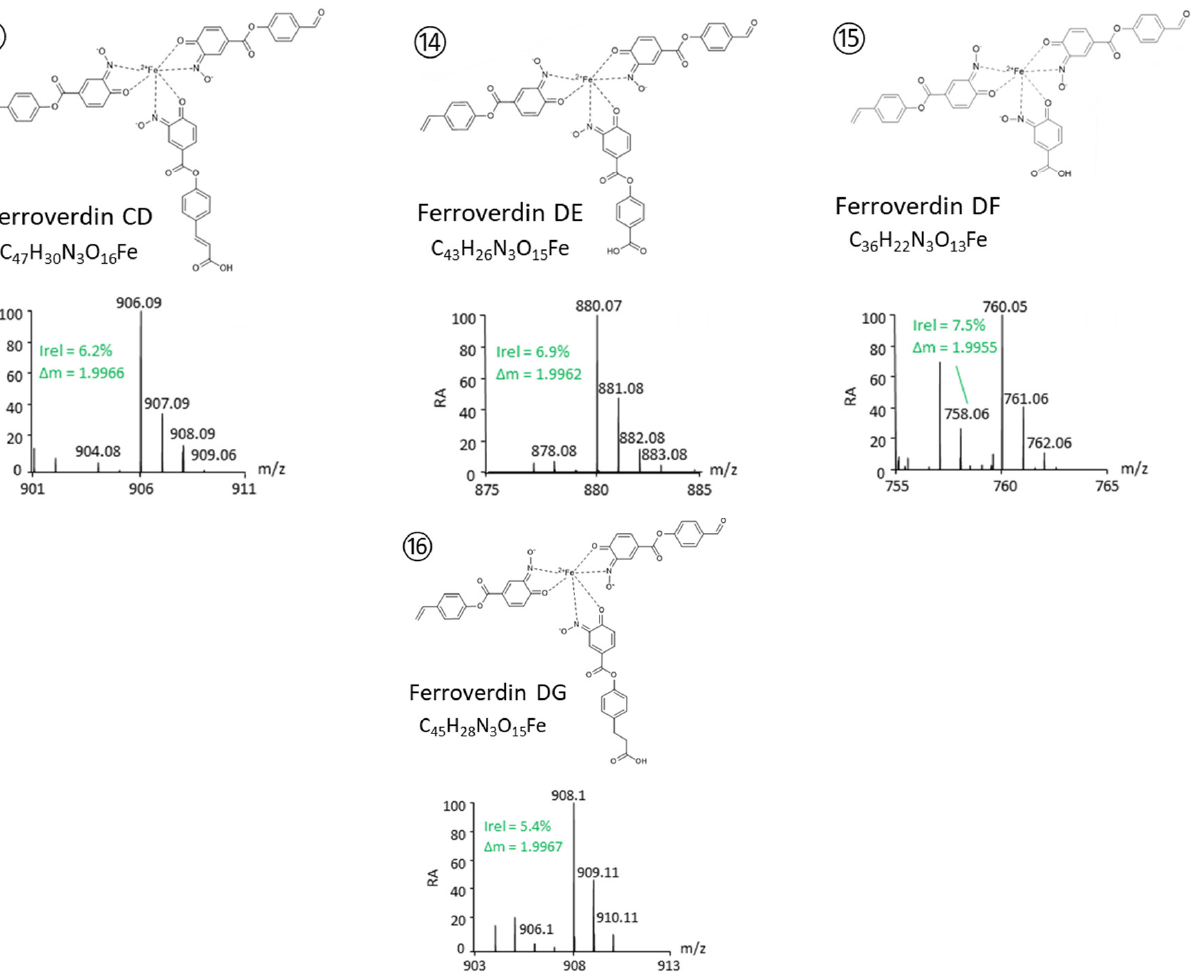
Figure 2. Structure proposed for new ferroverdins. Compound identification and structure elucidation was performed by UPLC–MS/MS. Each compound was identified based on its exact mass and isotope pattern and the analysis of the MS/MS spectra obtained by molecular ion fragmentation as detailed in supplementary Figure S1.